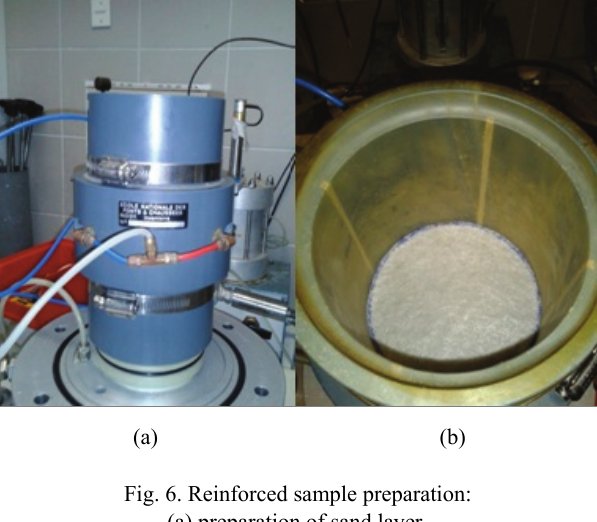
Fig. 6. Reinforced sample preparation: (a) preparation of sand layer, (b) geotextile emplacement into soil